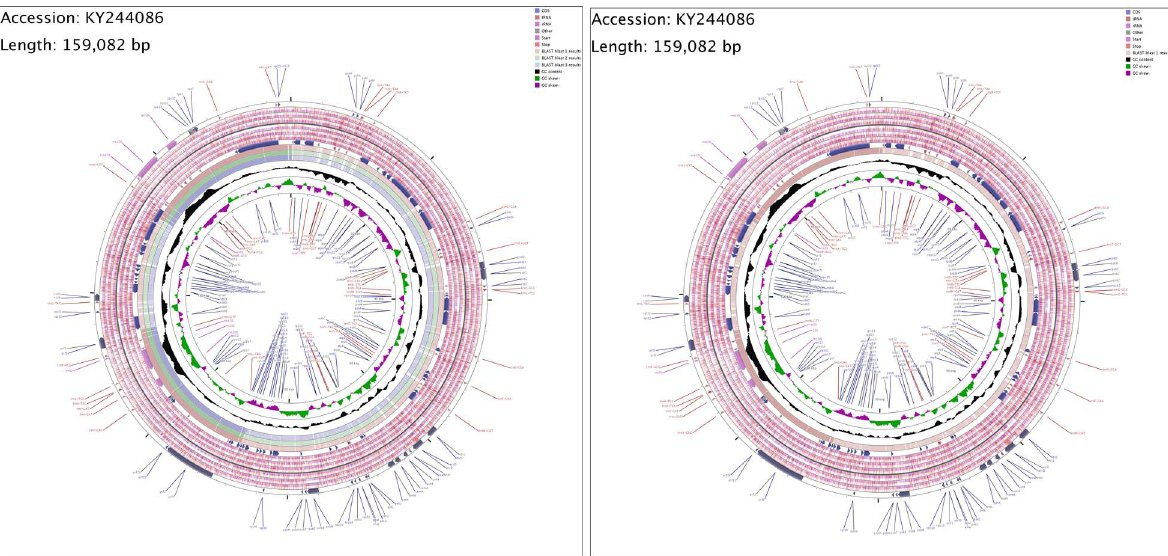
Fig 10. Comparison of chloroplast genome of five Ulmus species. Fig 10A and Fig 10B were take U pumila L as contrast, In Fig 10A blast 1 to blast 3 were U . davidiana Planch.var. japonica (Rehd.) Nakai, U . macrocarpa Hance., and U . davidiana Planch. Fig 10B blast 1 was U . laciniata Mayr. Ring 1: Forward strand features from Ulmus pumila L. Rings 2,3,4: Forward strand start and stop codons in reading frames 3,2,1. Rings 5,6,7: Reverse strand start and stop codons in readingframes 1,2,3. Ring 8: Forward strand features from U .